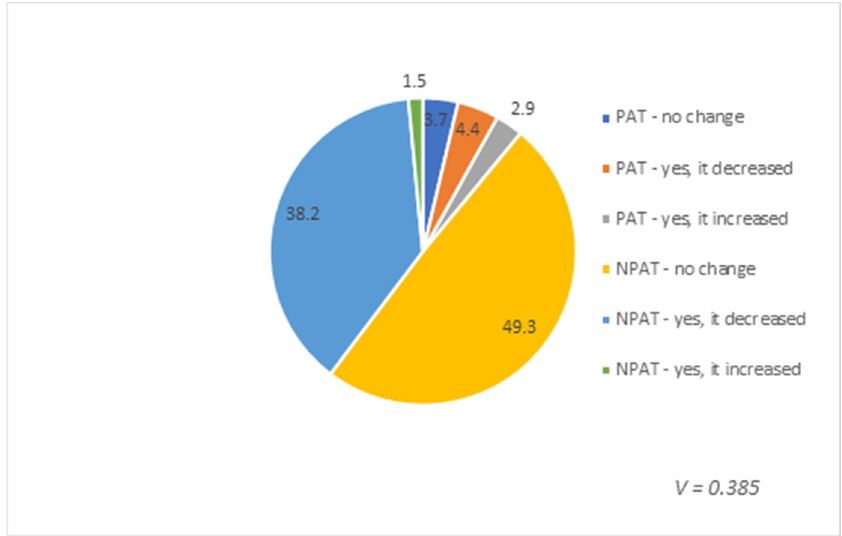
Figure 6. Relationship between postoperative adjuvant chemo- and / or radiotherapy and change in the